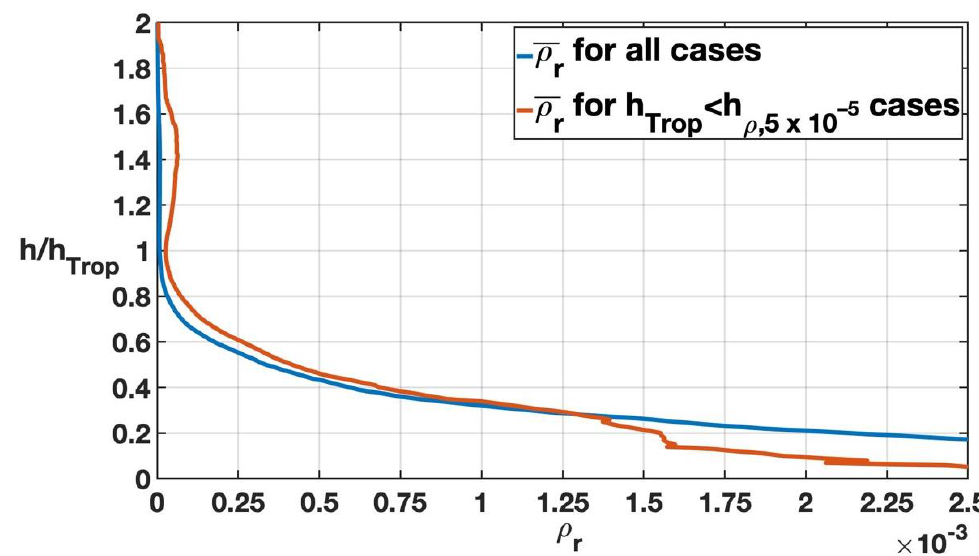
Figure 18. Mean values of mixing ratios for all the cases (blue) and for the cases with the starting altitude ℎ 𝜚,5×10 −5 higher than the tropopause (red). Altitudes are scaled with respect to tropopause elevations.